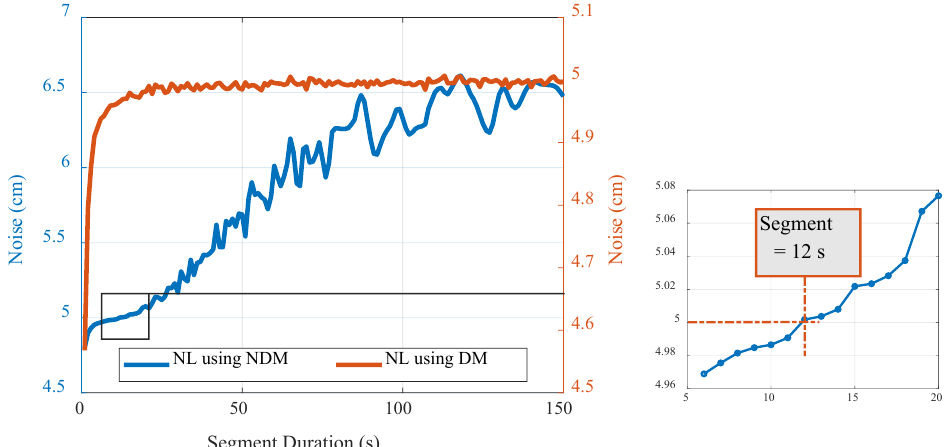
Figure 3. The changes in the estimated noise level (NL) with the segment duration using the non- differential method (NDM, blue curve) and differential method (DM, red curve). The small window on the right shows the detailed image of NDM within 6–20 s.